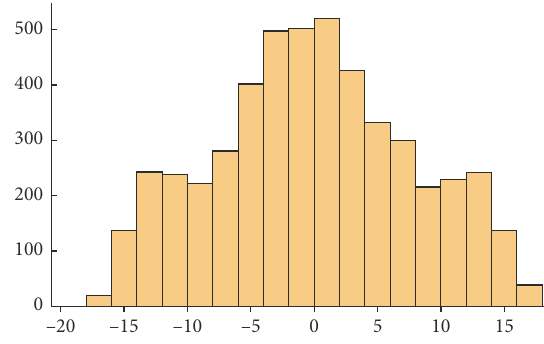
Figure 6: Histogram for the time series 𝑀𝑃 𝑡